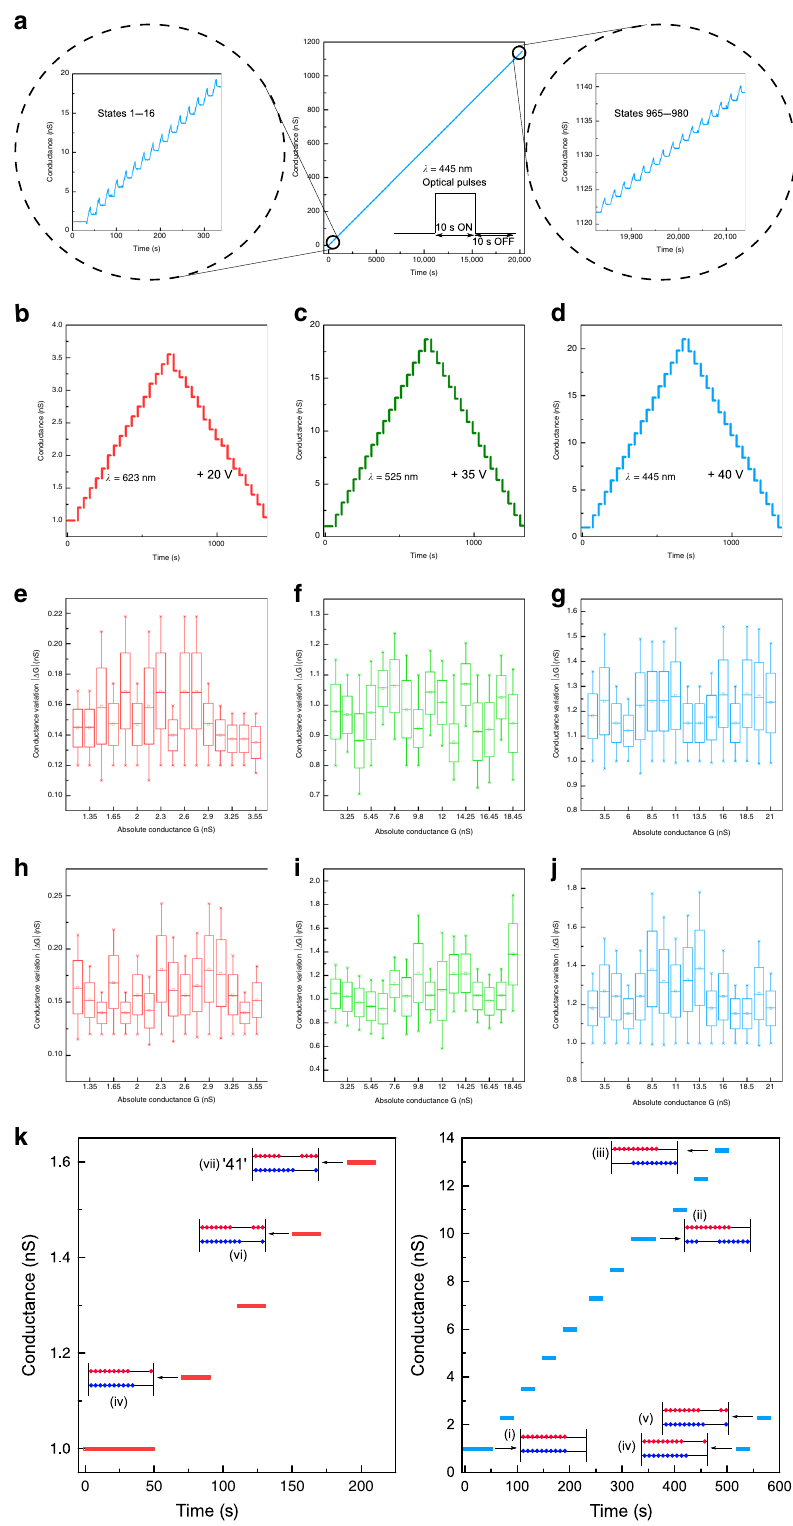
followed by programming steps equivalent to the addend ‘ 4 ’ . When the sum reached ‘ 10 ’ (stage-iii), the unit ’ s place PEN was RESET to the initial conductance state by appropriate electrical pulses (amplitude = + 40 V, pulse width = 1 s, number = 10, Supplementary Note 5, Fig. 9a), represented by extreme left shift of all the blue beads (stage-iv). Concurrently, the second PEN